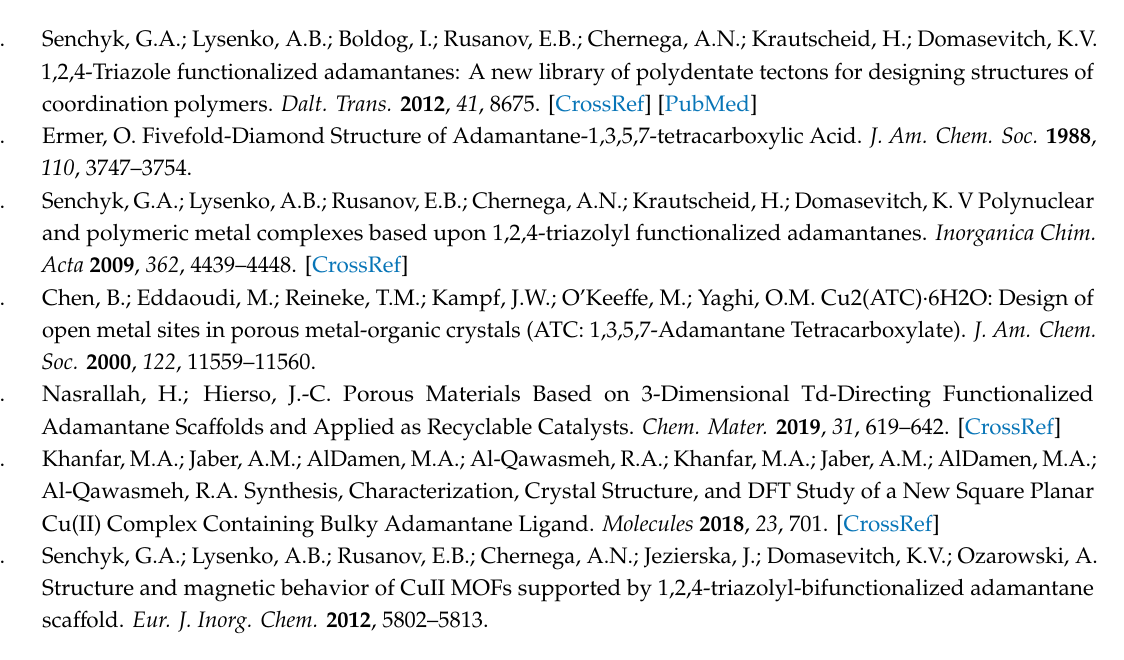
Figure S1: Representation of a layer built from 1D chains of the complexes an solvate molecules for 1 and 2 , Figure S2: Representation of 1D chains of 1 (a), 2 (b) and 3 (c) showing their similarity, Figure S3: Structure view along 1D chain showing di ff erence between 3 (a) and 1 – 2 (b, on the example of 1 ), Figure S4: Representation of torsion angles of trzadc – and mtrzadc – ligands on the example of trzadc – , Figure S5: Intermolecular hydrogen bonds between molecules of trzadcH , Table S1: Torsion angles (deg.) for trzadc – and mtrzadc – ligands in the complexes 1 – 4 ., Figure S6: The PXRD patterns for compounds 1 – 4 , Figure S7: IR Spectra of trzadc , mtrzadc , dmtradc (a); IR spectra of ttzadc , mttzadc (b); IR spectra of trzadc and compounds 1–3 (c); IR spectra of mtrzadc and compound 4 (d), Figure S8: TGA / DSC curves for compounds 1 – 4 , Figure S9: NMR spectra of the trzadc, Figure S10: NMR spectra of the mtrzadc, Figure S11: NMR spectra of the dmtrzadc, Figure S12: NMR spectra of the ttzadc, Figure S13: NMR spectra of the mtrzadc, Figure S14: Residual electron density map (0.55 eÅ –3 level) for the complex 1 with full occupancy of coordinated and solvate water molecules. CCDC 1922178 ( 1